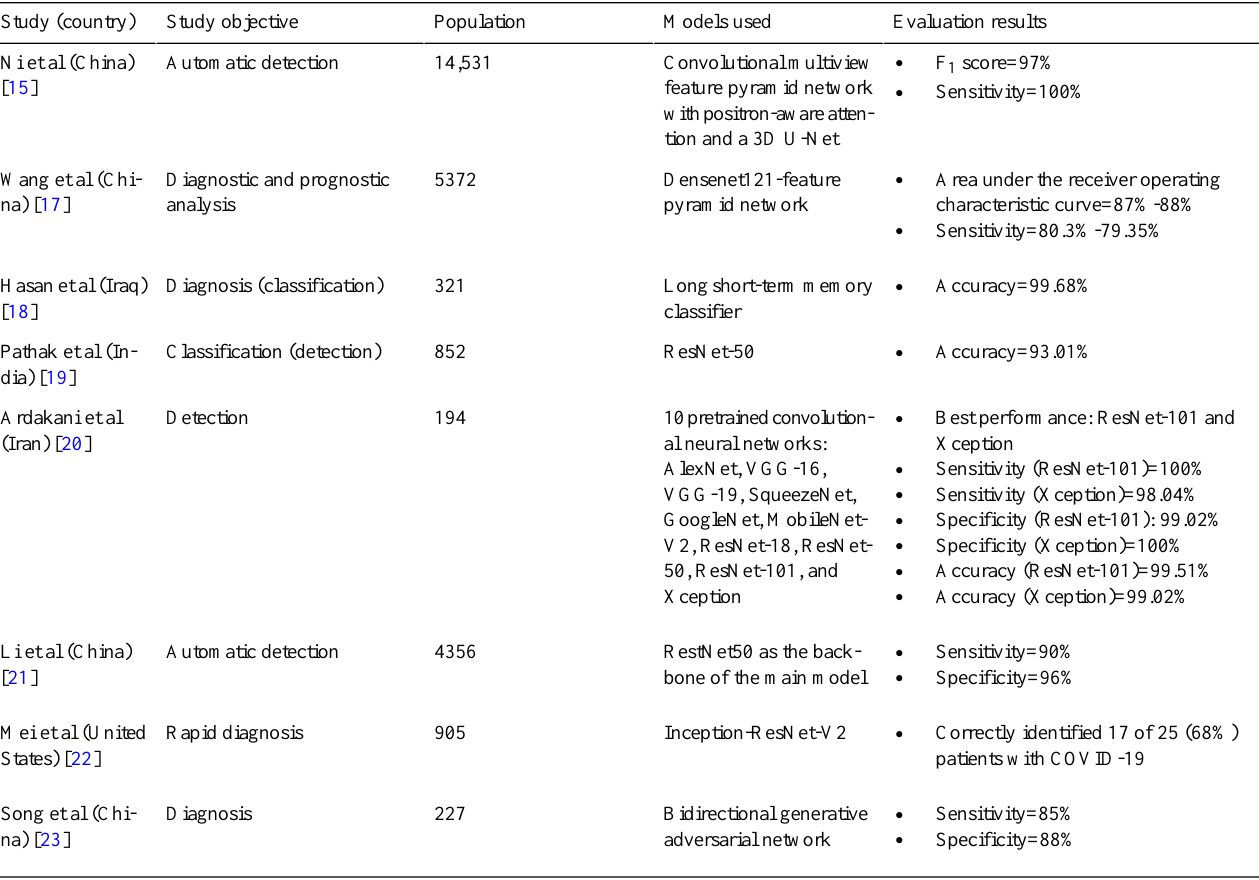
Table 1. Studies evaluating machine learning algorithms used for COVID-19